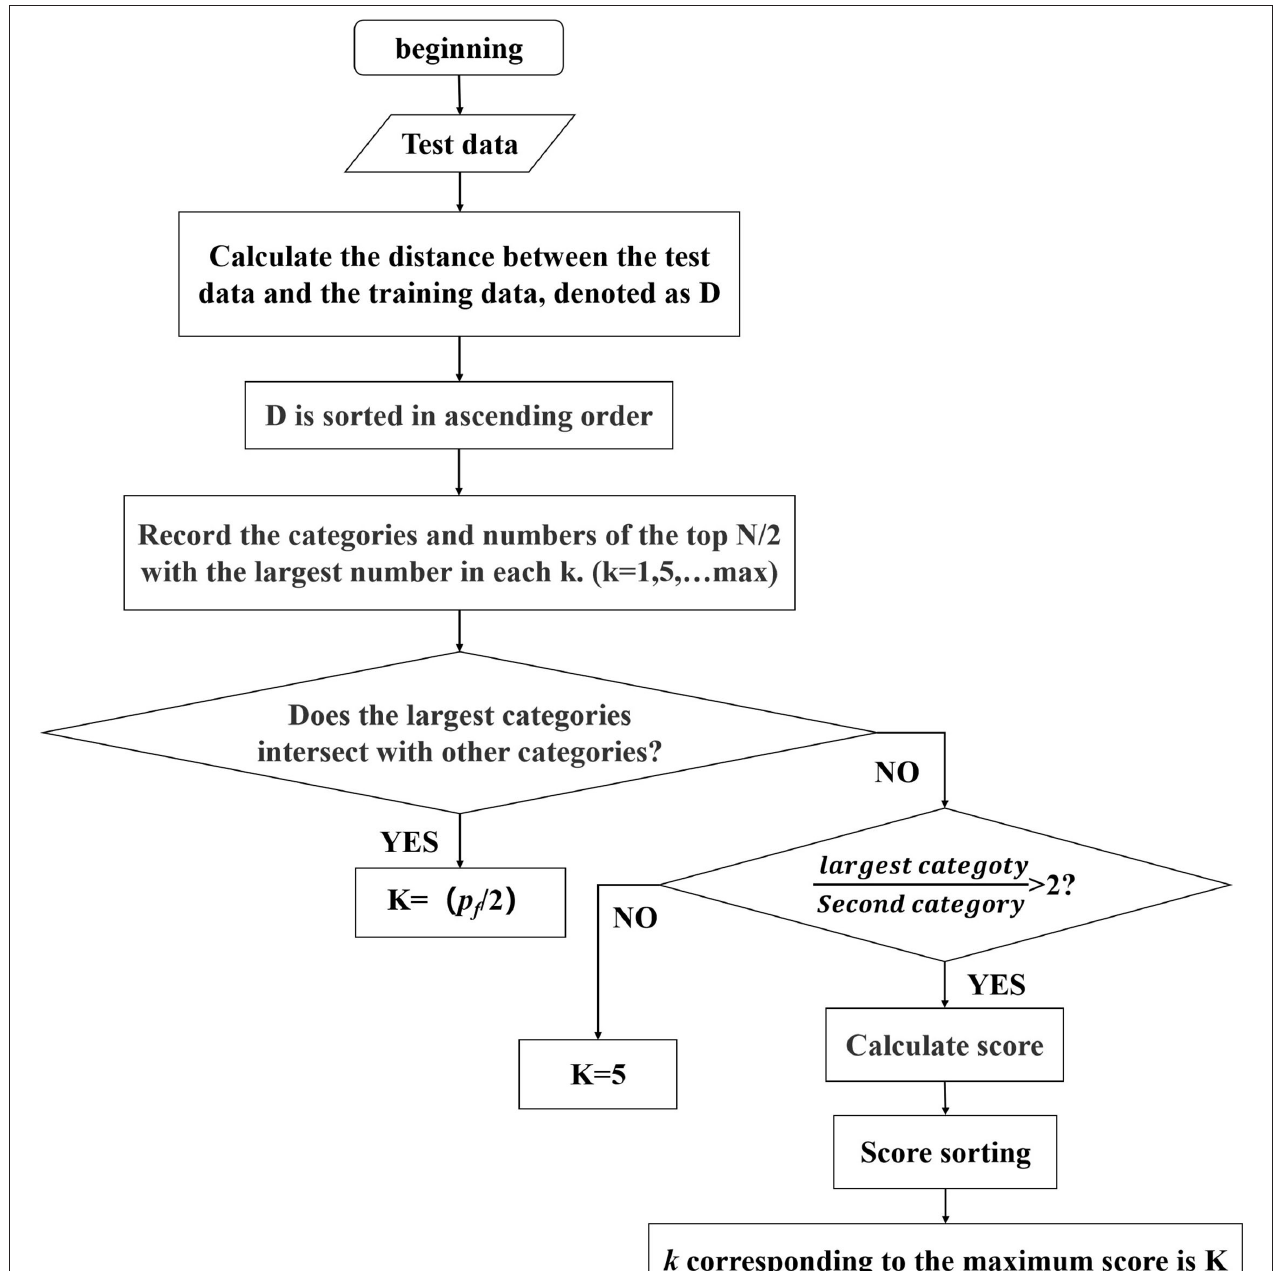
FIGURE 4 | The process of adapting K